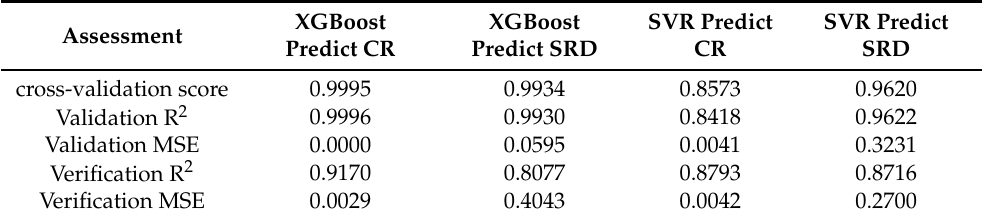
Table 5. Model assessment in terms of model validation and verification. The cross-validation score is the average value of R 2 of all testing folds. Validation R 2 and Validation MSE are the values during the model validation. After validation, 78 cases different from training and test datasets are used for verification. The verification R 2 and verification MSE are the results of model performance assessment during